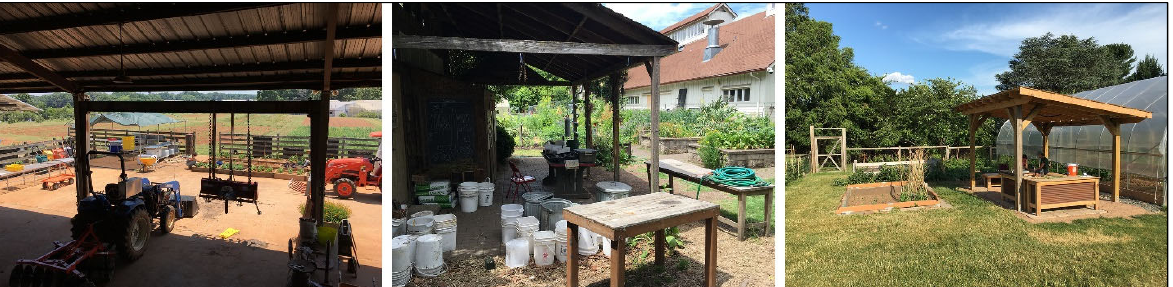
Figure 2. Farm Hubs: Large (Left), Medium (Center), Small